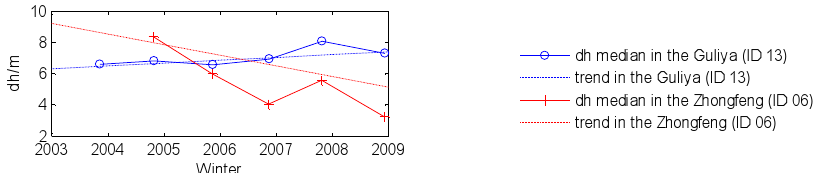
Figure 2. Glacier elevation changes derived from the elevation difference (dh) values between ICESat and SRTM for the Guliya and Zhongfeng glaciers. For a better visual representation, median dh values in each laser period are shown. Trends were fit through all dh values in autumn and winter seasons.